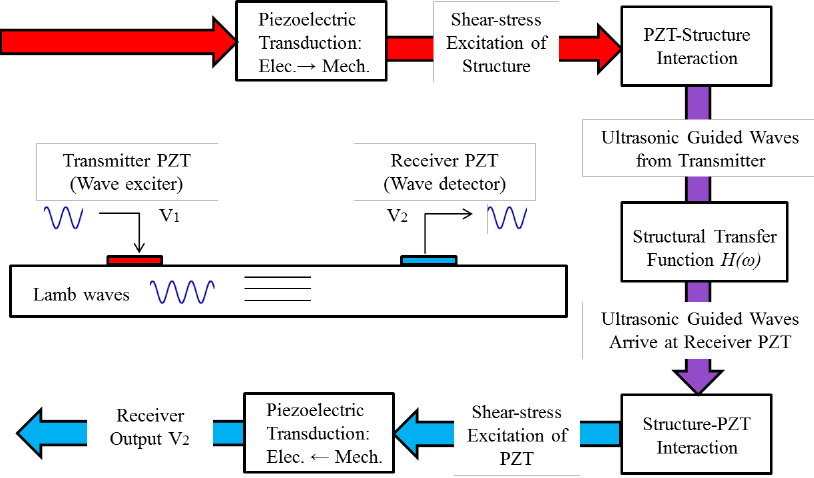
Figure 7. The flowchart of a PZT pitch-catch configuration for Lamb